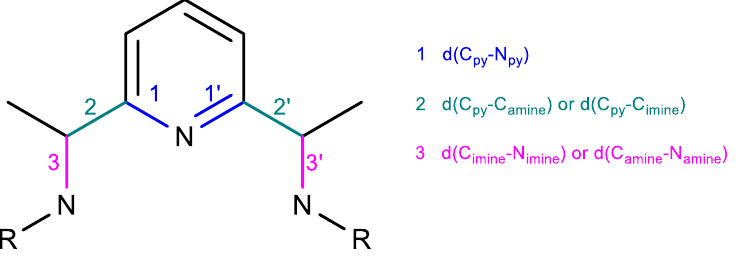
Scheme 3. Definition of the factors to calculating the structure parameter Δ in the